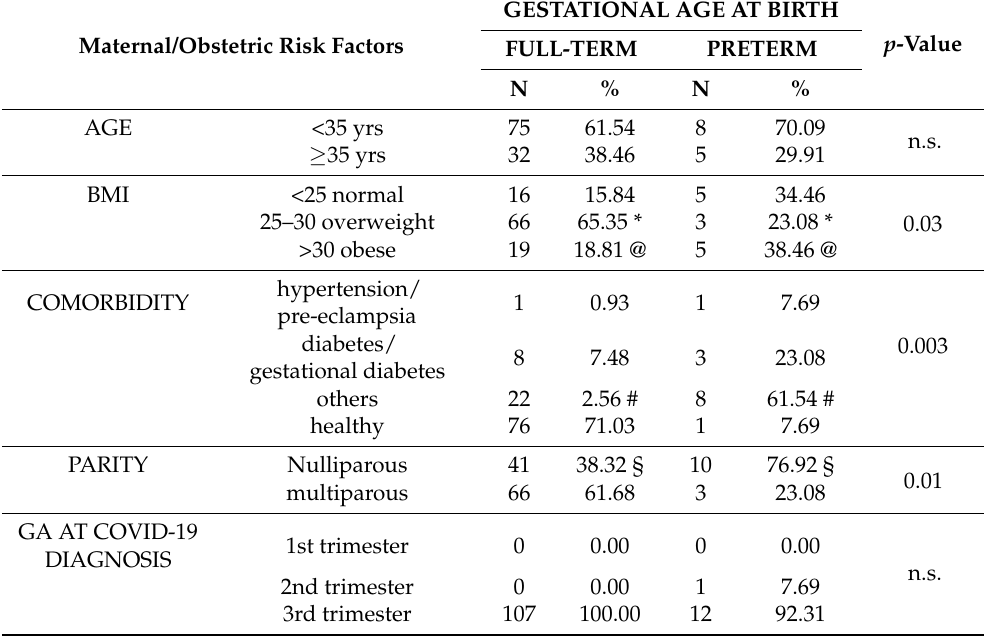
Table 4. Maternal characteristics and gestational age at birth (full-term vs. preterm birth). LEGEND: OVB (operative vaginal birth), SVB (spontaneous vaginal birth), CS (cesarean section); *, @, #, §, a, b, c: subgroups significantly different p < 0.001; n.s.: not statistically significant, p > 0.05. The percentages considered the missing data, which were not reported for reasons of